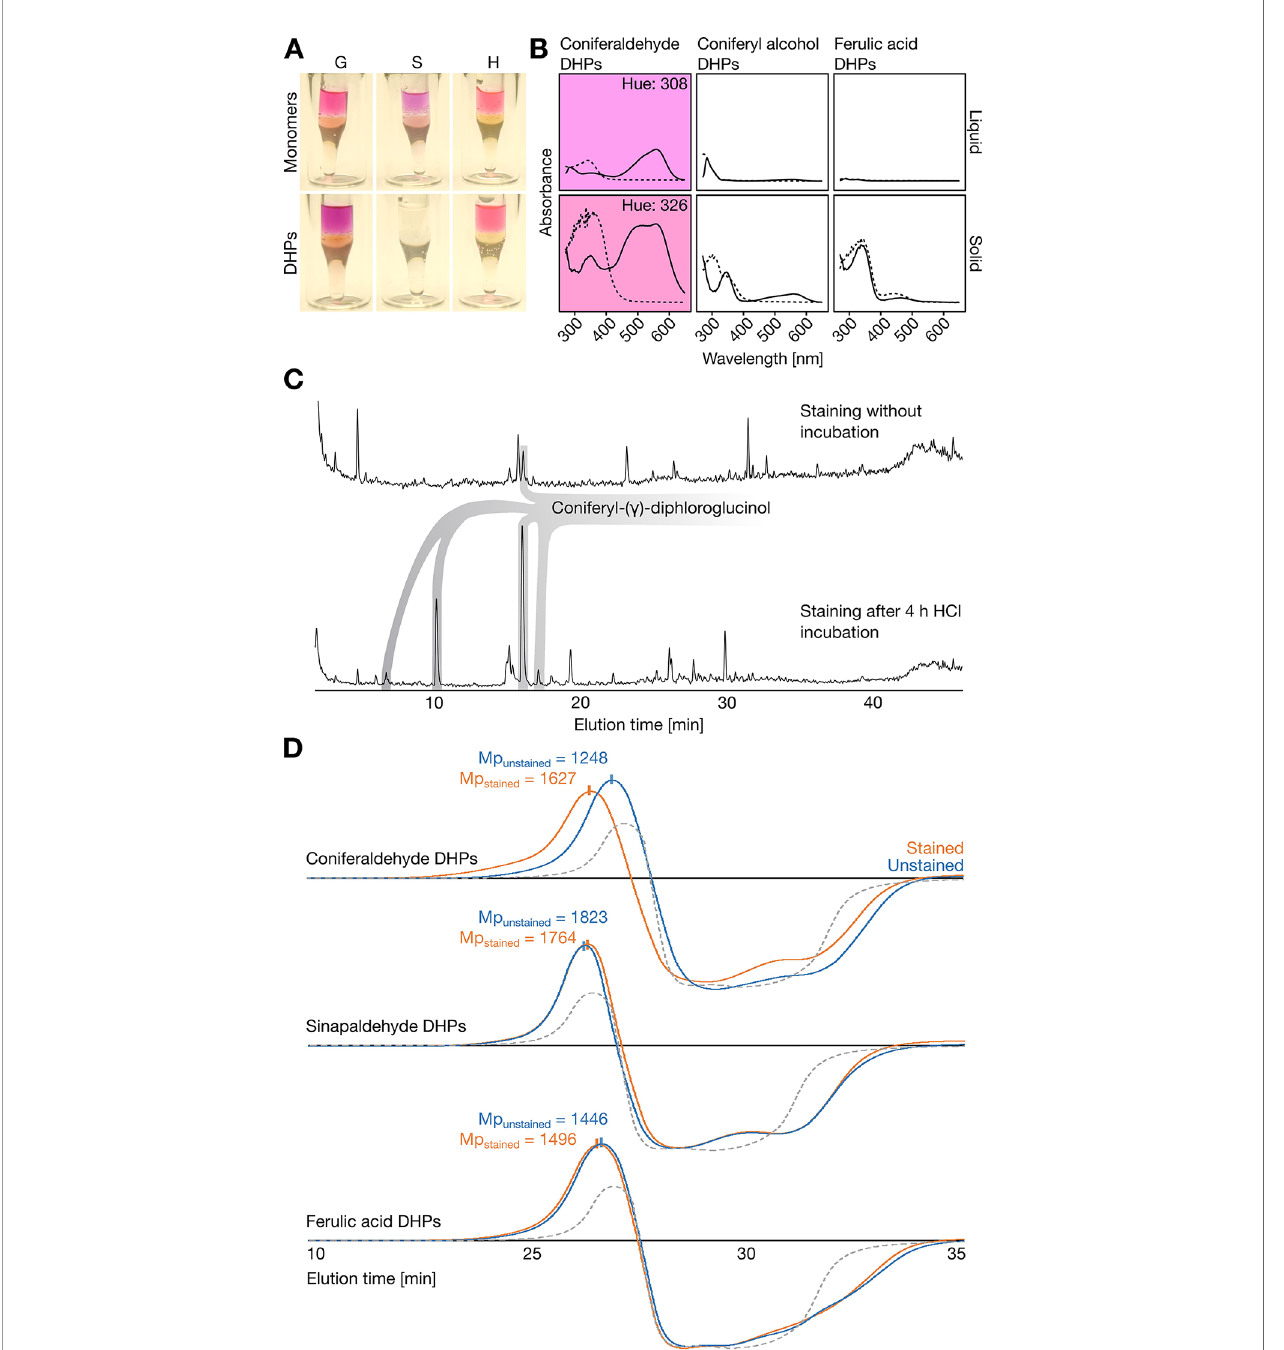
FIGURE 2 | Reactivity of synthetic lignin-like dehydrogenation polymers (DHPs) with the Wiesner test. (A) Methanol solubilized H , G , or S C 6 C 3 monomers and DHPs after staining for 1 min with 0.5% phloroglucinol/6 M HCl and subsequently adding a few droplets of 6 M NaOH without mixing, thus forming a pH gradient from top to bottom. (B) Absorbance spectra of G C 6 C 3 aldehyde, alcohol, and acid DHPs solubilized in methanol (liquid) or dried onto 3MM Whatman paper (solid) and stained with the Wiesner test. Chromophores are indicated by the purple background in the corresponding hues for liquid (308°) and solid (326°) state. The small difference in hue suggests a minor in fl uence of solvent effects on the sample reactivity to the Wiesner test. (C) LC-MS pro fi les of reaction products detected by staining with 6 M HCl/0.5% phloroglucinol following 0 and 4 h of 6 M HCl treatment. Both chromatograms are relative to total ion current. (D) GPC-RID pro fi les of G or S C 6 C 3 acid and aldehyde DHPs solubilized in methanol either unstained (un) with 6 M HCl or stained (st) with 0.5% phloroglucinol/6 M HCl (compared to unstained methanol only in gray dotted lines) before neutralization with 6 M NaOH. Mp indicates the molecular weight at the peak maximum for each condition. All chromatograms have the same intensity